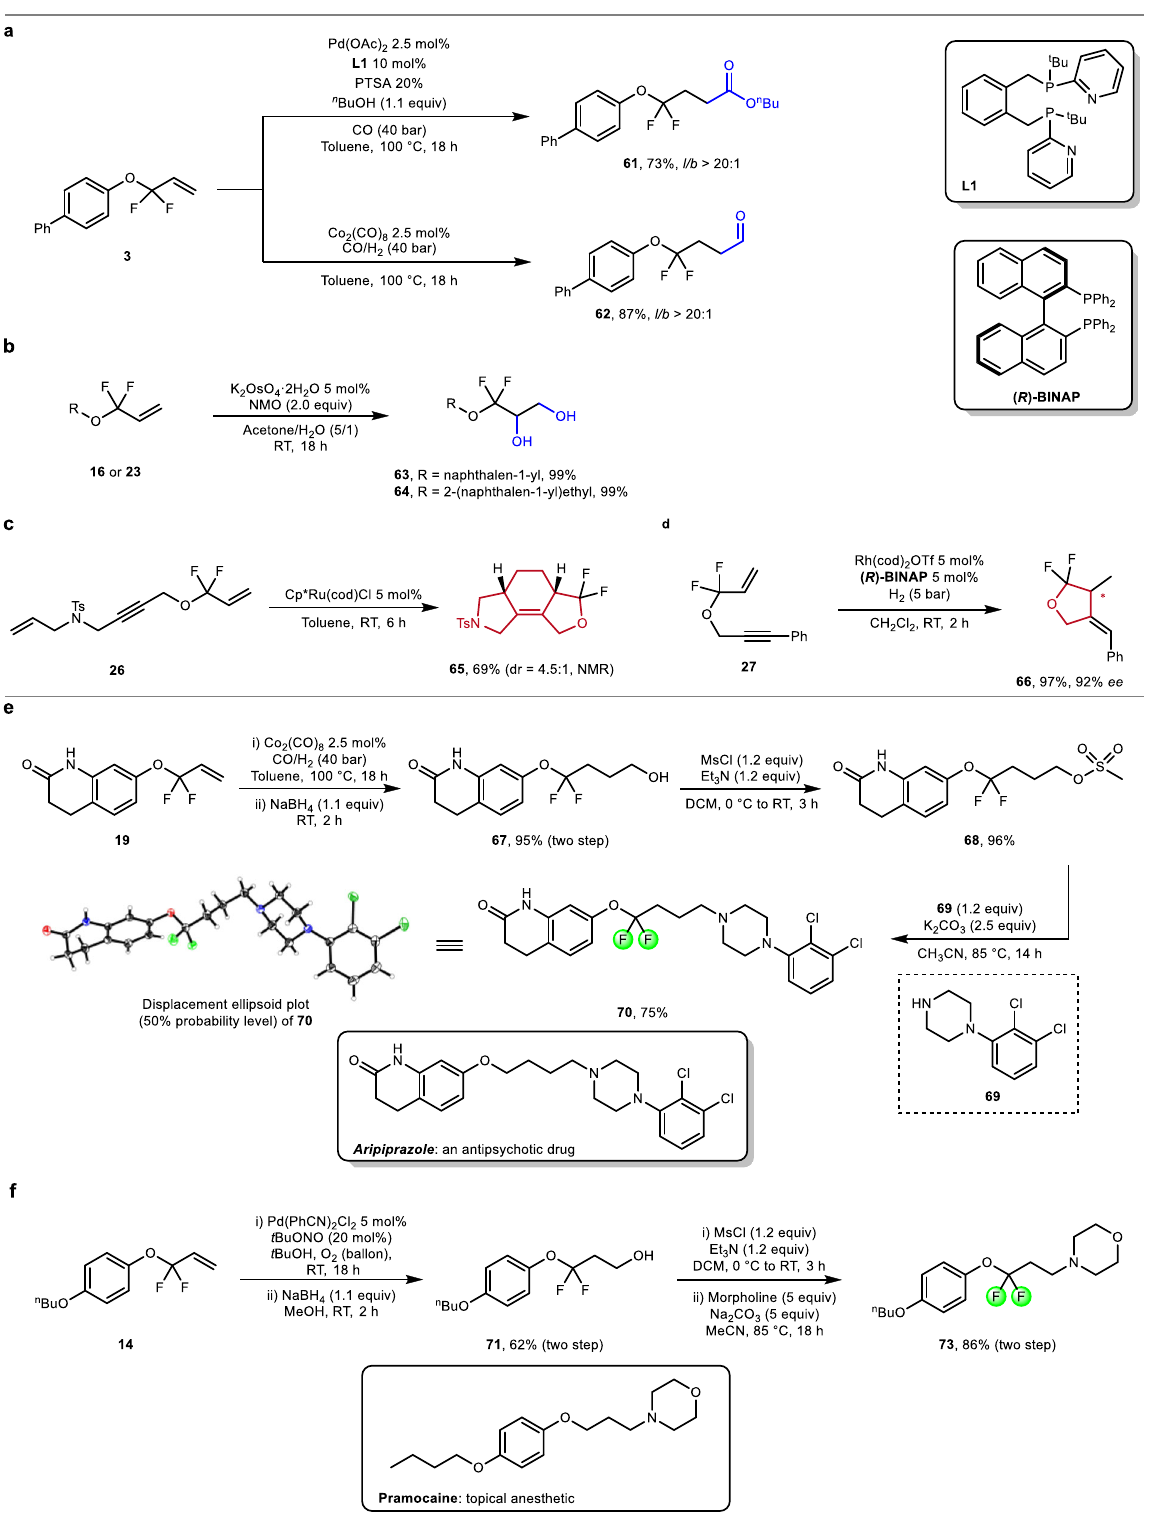
Fig. 5 Synthesis of gem -di fl uorinated analogs of drugs and further valorization of gem -di fl uorinated allyl ethers. a Transition-metal catalyzed carbonylation of di fl uorinated alkene 3 . b Dihydroxylation of 16 and 23 to give di fl uorinated 1-aryl-glycerols. c Ruthenium-catalyzed [2 + 2 + 2] co- cyclization of diene-yne 26 . d Rhodium-catalyzed reductive cyclization of 1,6-enyne 25 . e Practical procedures for the synthesis of OCF 2 -Aripiprazole 70 . f Four-step protocol for the synthesis of OCF 2 - Pramocaine 73